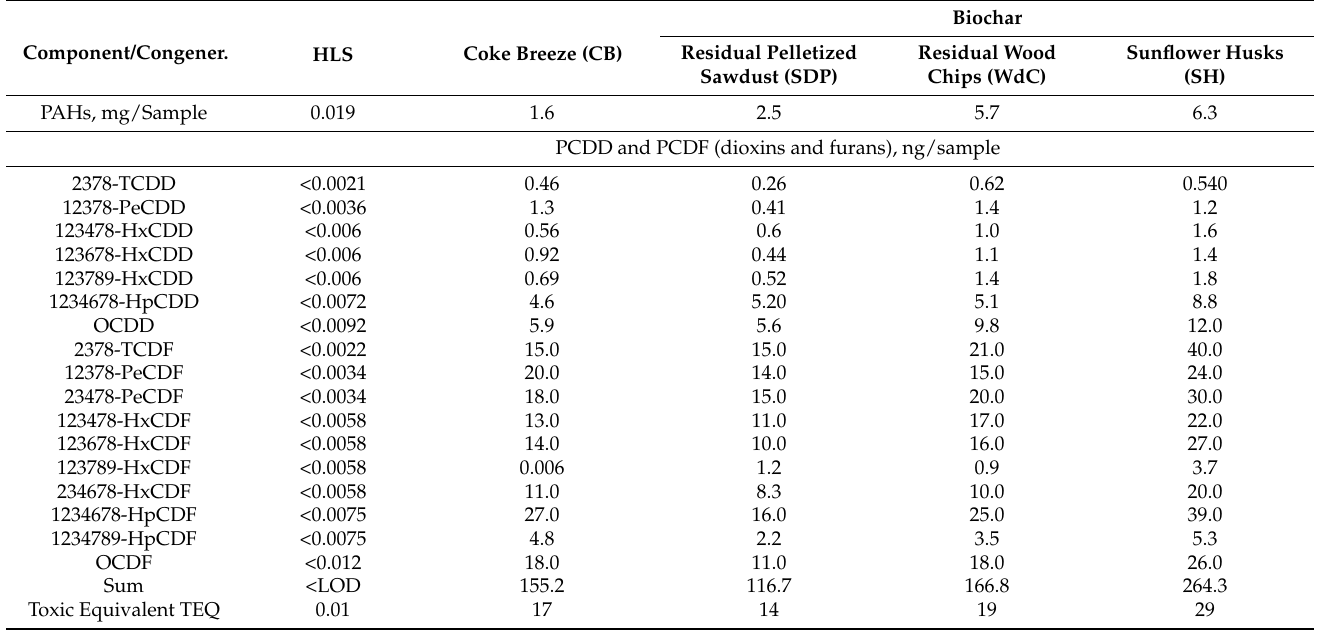
Table 8. The content of polyaromatic hydrocarbons (PAHs), dioxins and furans in HLS, and dust collected from the catalytic ceramic filter after the sintering process with coke breeze and mixed fuels.